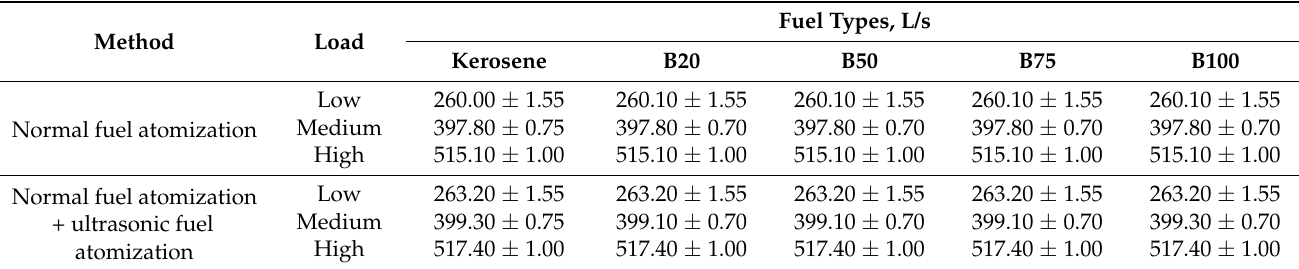
Table 3. Results of air-flow rate against the engine load for all the different fuel types: (a) kerosene, (b) B20, (c) B50, (d) B75 and (e) B100.